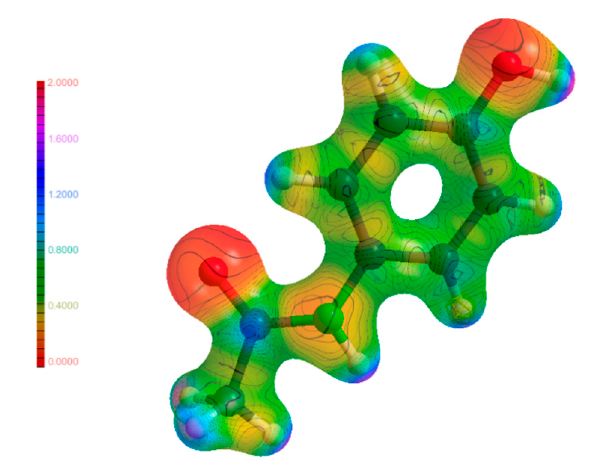
Figure 11 . Molecular electrostatic potential maps of ( 1 ) mapped on an isosurface of ρ .